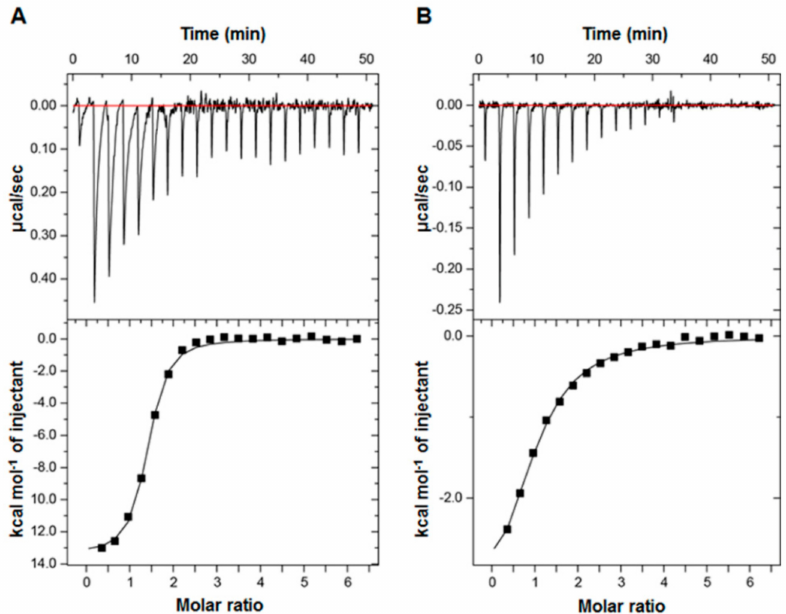
Figure 3. Binding affinity measurements of MED25 ACID with p53 p53TAD. The equilibrium dissociation constants (K d ) between MED25 ACID and full-length p53TAD (K d , 0.8 ± 0.1 µ M) ( A ) and p53TAD2 peptide (K d , 8.1 ± 0.8 µ M); ( B ) were determined by isothermal titration calorimetry